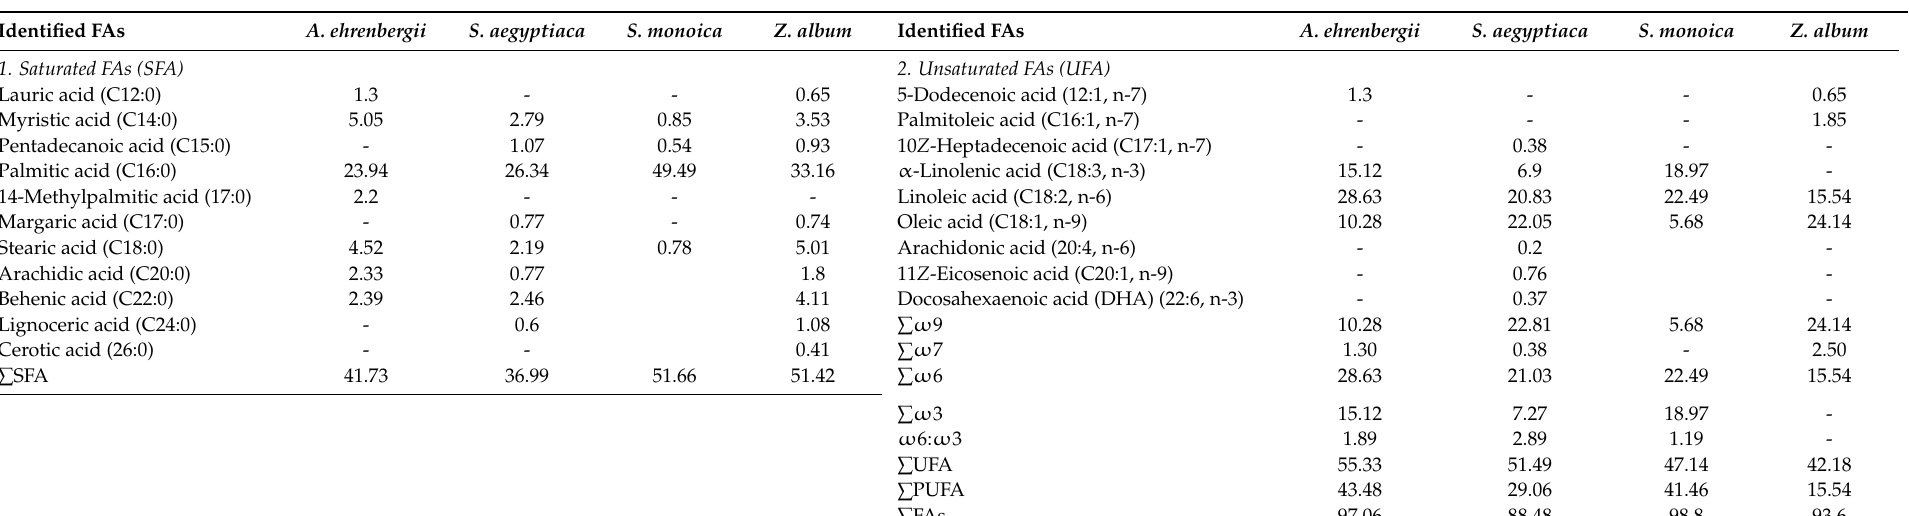
Table 4. Fatty acid (FA) compositions (relative %; n = 2) of the investigated Red Sea